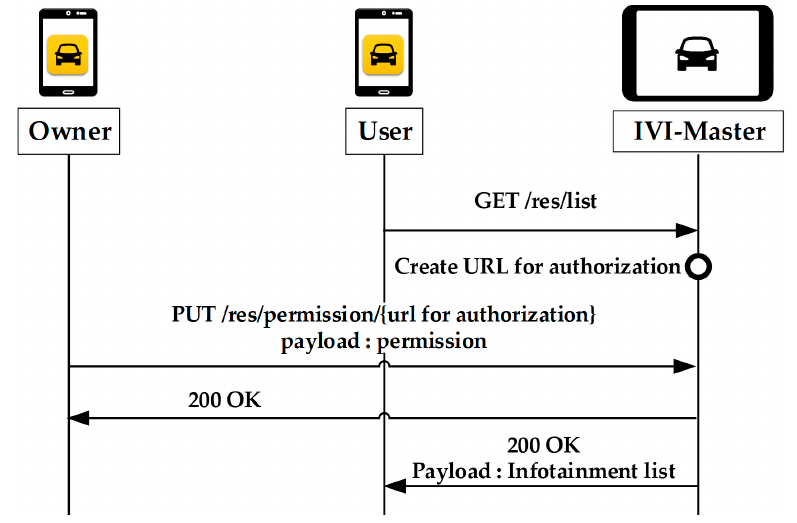
Figure 10. Request of resource list by user.